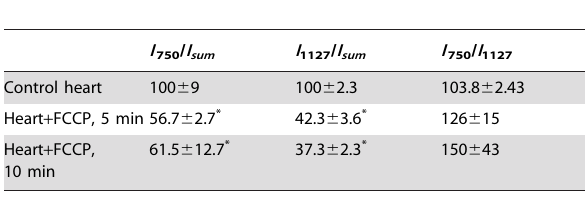
Table 2. Relative intensity of cytochromal peaks normalized to the sum of the whole spectrum intensities in normal perfused heart and under application of